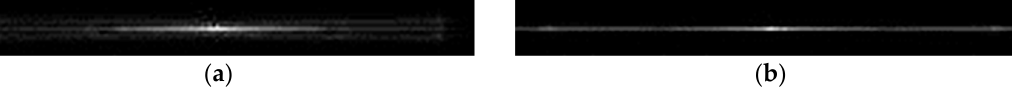
Figure 13. ( a ) Example of power spectrum obtained by performing FFT on one of